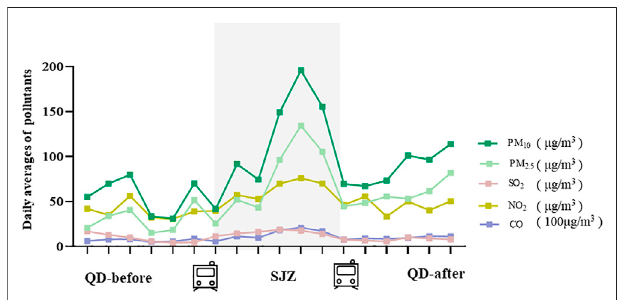
FIGURE 1 | Differences in air quality between Shijiazhuangand Qingdao during the study period. QD-before: 2020.12.12-2020.12.17 Qingdao